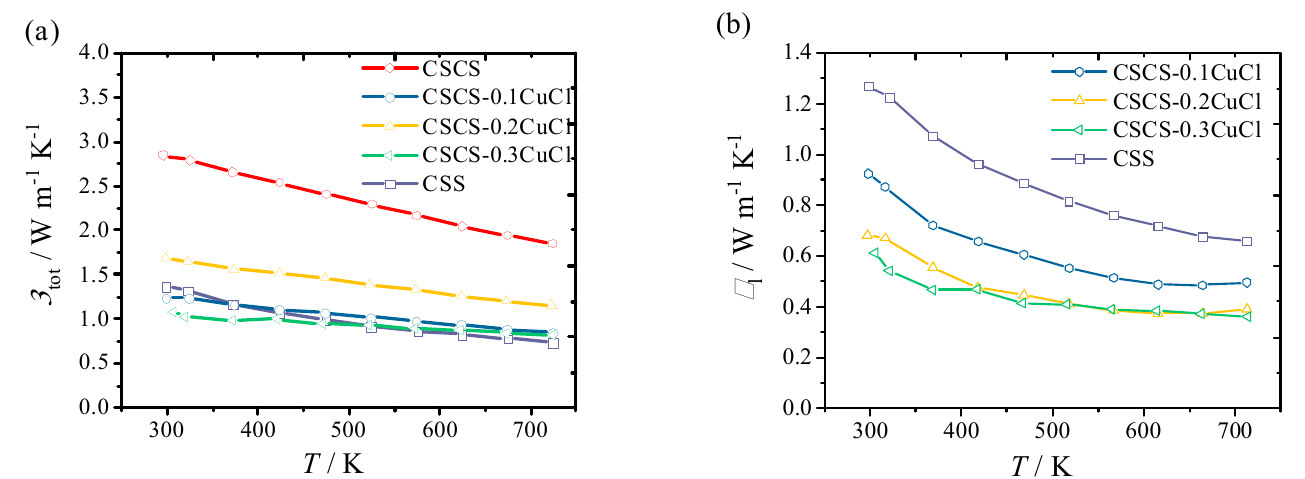
the testing temperature range. An obvious drop in κ tot from 2.84 to 1.23 W m − 1 K − 1 was obtained at room temperature.